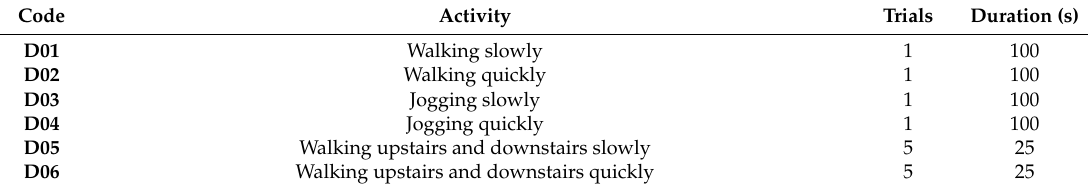
Table 3. Types of ADLs in SisFall